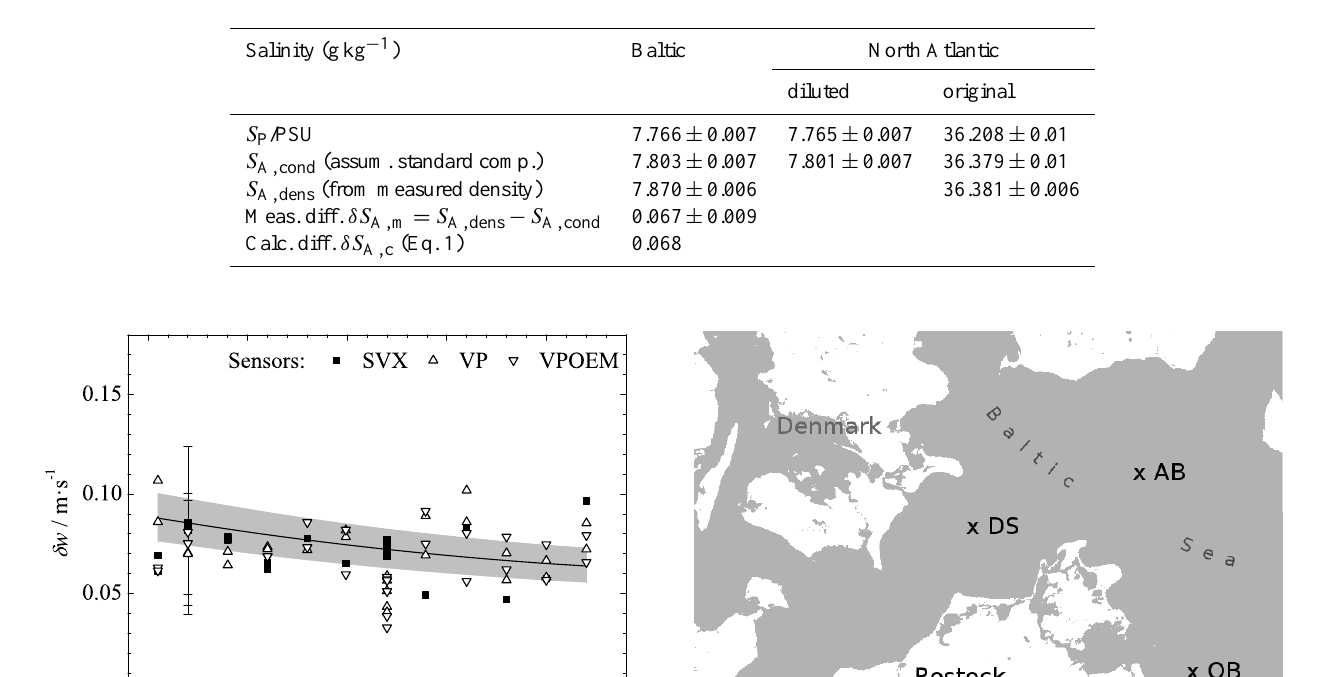
Table 2. Salinity estimates for the samples used and salinity differences related to the composition anomaly for the Baltic seawater sample, including standard uncertainties.